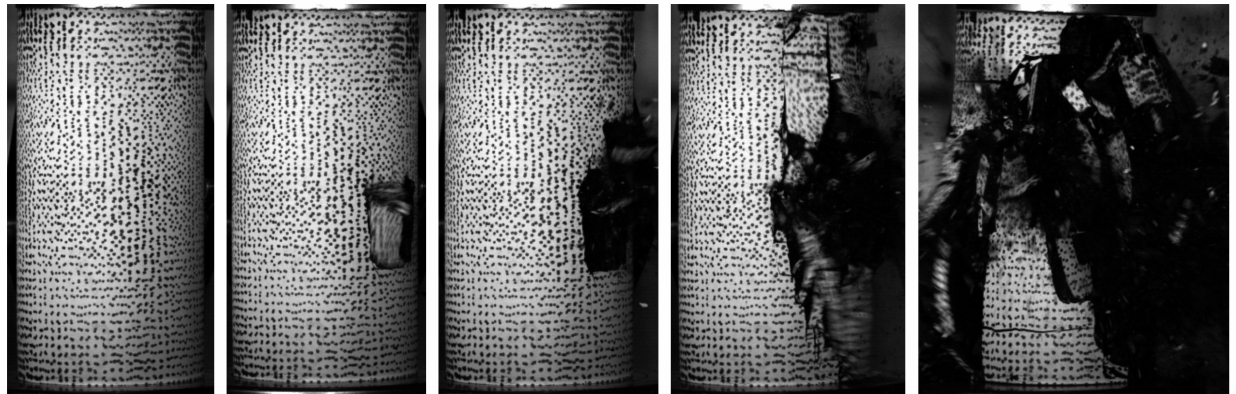
Figure 4. The failure process of specimen